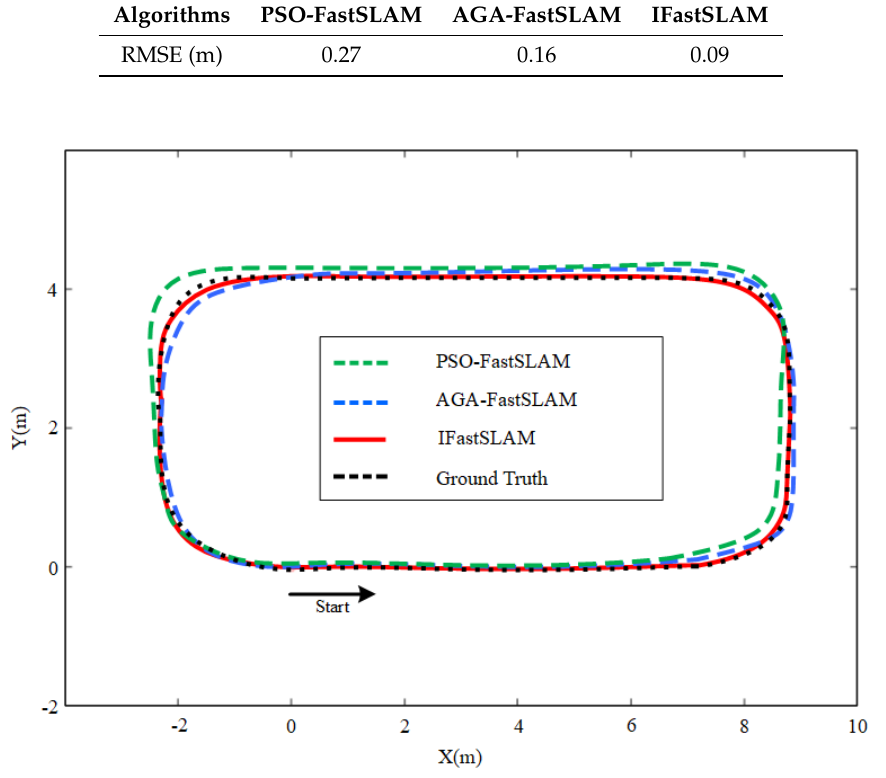
Figure 13. The estimated trajectory for different algorithms in the field